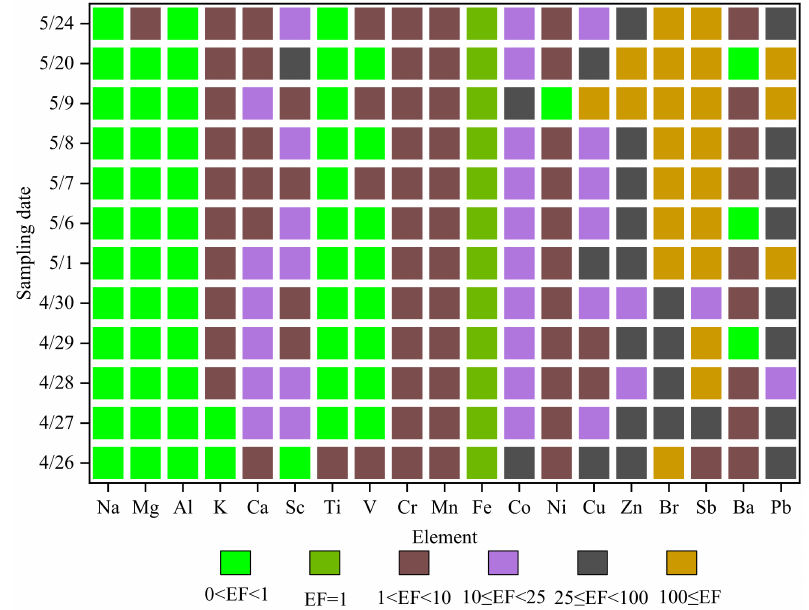
Figure 7. Results of enrichment factor analysis based on the XRF